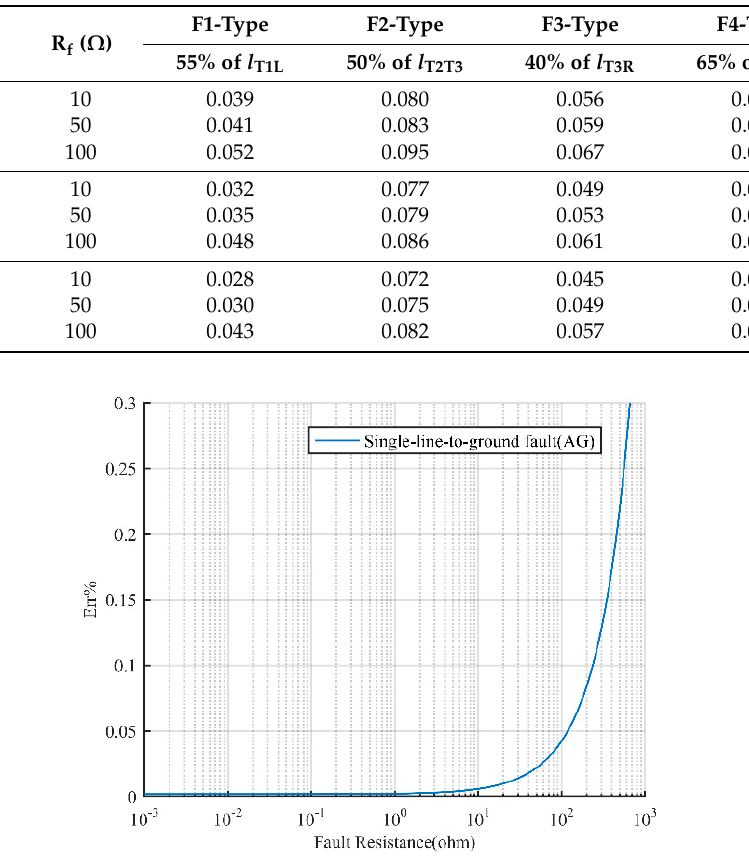
Table 6. Fault location error ( Err %) for single-phase faults with influence of fault inception angle (FIA) and fault resistance.